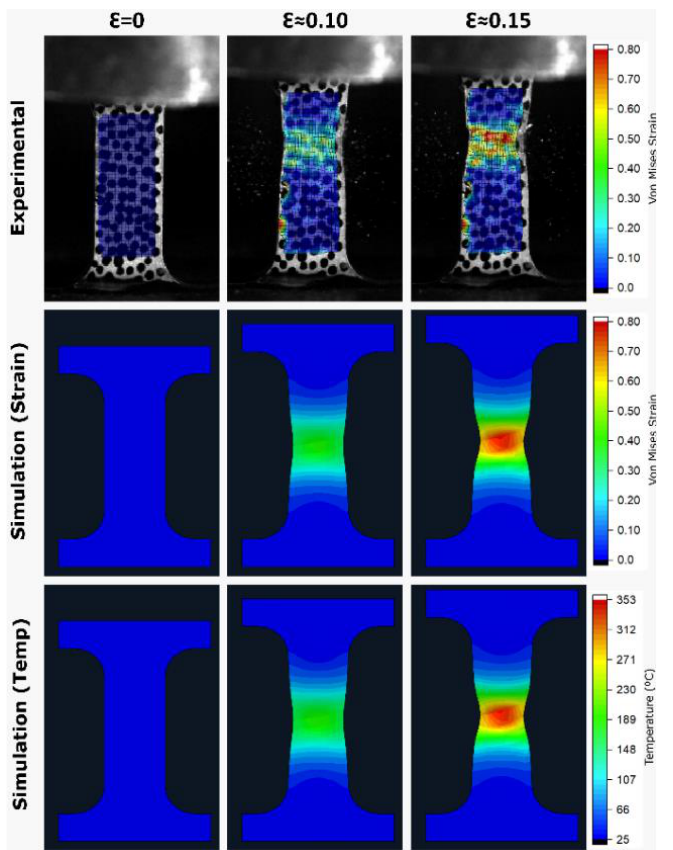
Figure 8: Experimental and computational strain distrubion for β-annealing dynamic test at RT and 500 s -1 (top) and the temperature distribution extracted from the simulated test